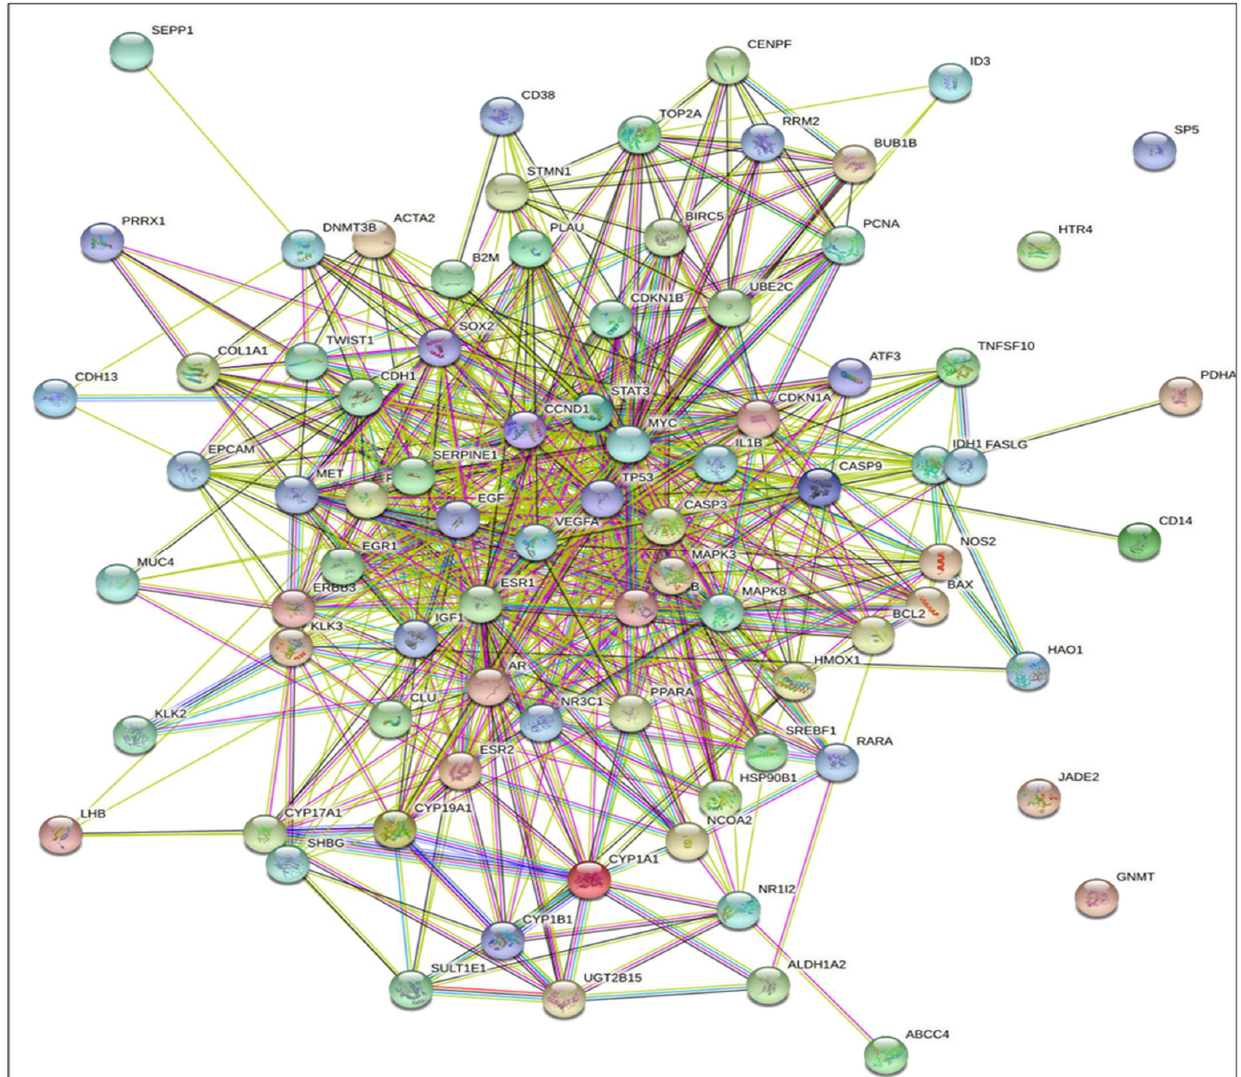
Figure 5. STRING database analysis of the protein–protein interactions (PPI) networks for the functional enrichment analysis yielded EPs and PBs influenced 81 overlapping genes (nodes) and the number of 698 edges with degree > 7, and PPI enrichment p -value < 1.0x10 −16 .